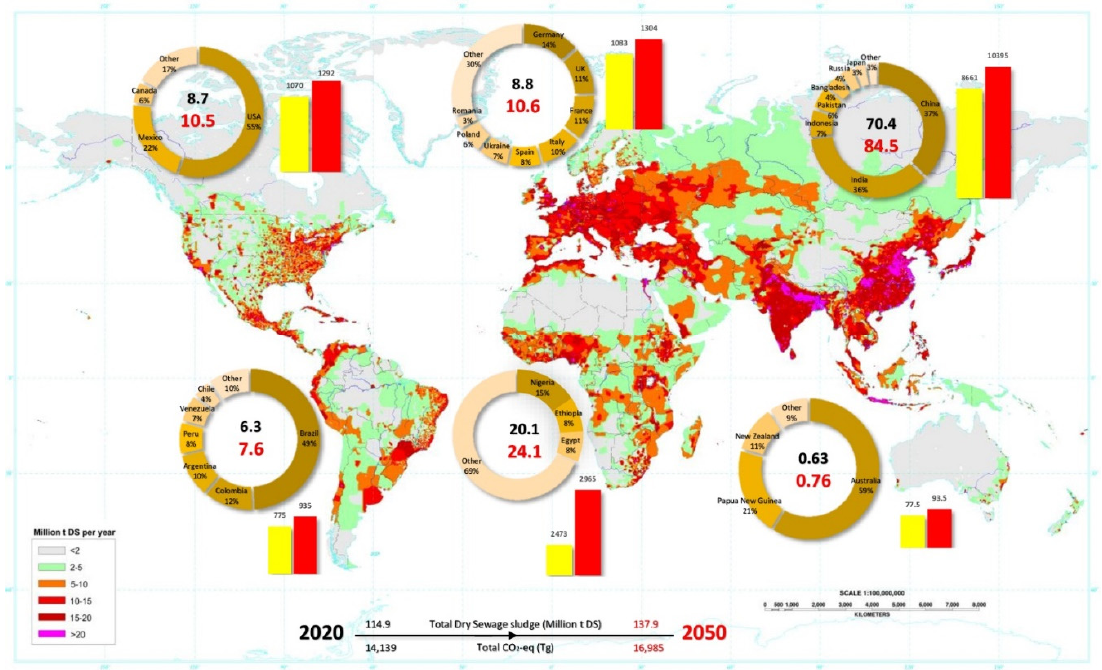
Figure 4. Global map of SS production and CO 2 -eq emissions from it. The inset doughnut graphs show the share of SS-producing countries by percentage from 6 continents (North and South America, Europe, Asia, Africa, and Oceania) in 2020. The inner bold numbers of the doughnut graphs indicate the total SS produced in 2020 (black), and the predicted values for 2050 (red) in million t DS. The bar graphs show CO 2 -eq emissions from different SS managements in 2020 (yellow) and the predicted values for 2050 (red) in Tg CO 2 -eq t − 1